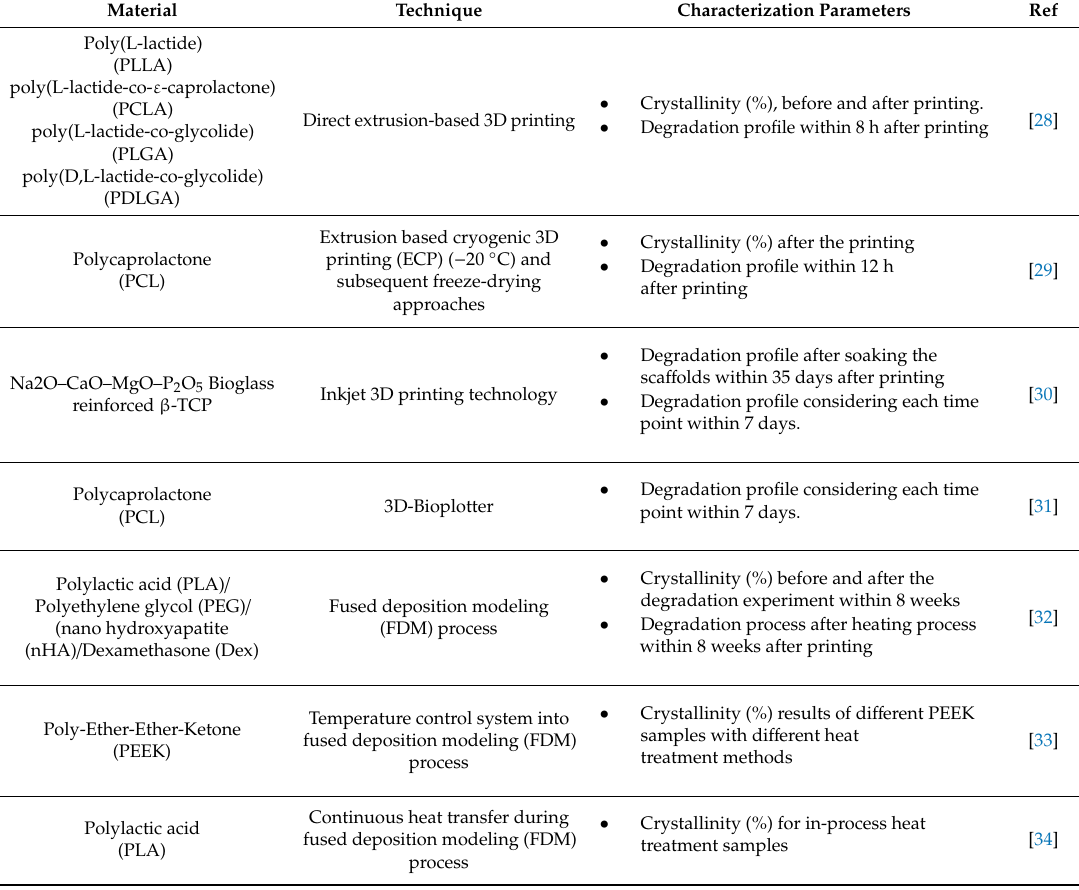
Table 1. Comparative table of the related work in regards characterization on 3D printed sca ff olds. Material Technique Characterization Parameters